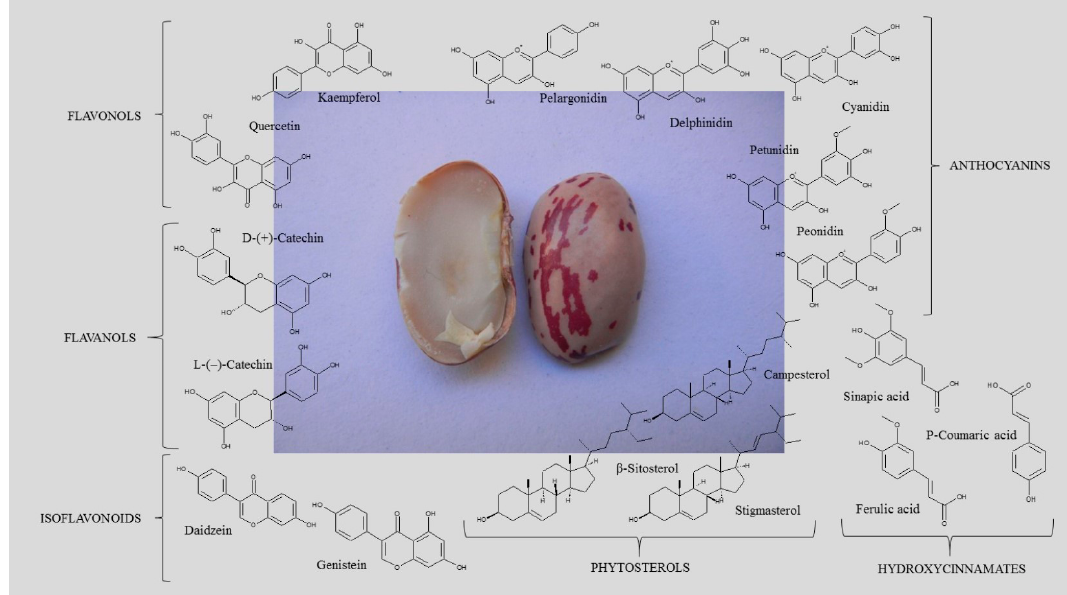
Figure 3. Occurrence of the main phenolic compounds and phytosterols in common bean ( Phaseolus vulgaris L.) seed tissues; phenolic compounds include hydroxycinnamates (ferulic acid, p-coumaric acid, and sinapic acid), anthocyanins (glycosides of cyanidin, delphinidin, pelargonidin, peonidin and petunidin), flavonols (glycosides of kaempferol and quercetin), flavanol units of proanthocyanidins (catechins), and isoflavonoids (daidzein and genistein); main phytosterols include β -sitosterol, stigmasterol, and campesterol.